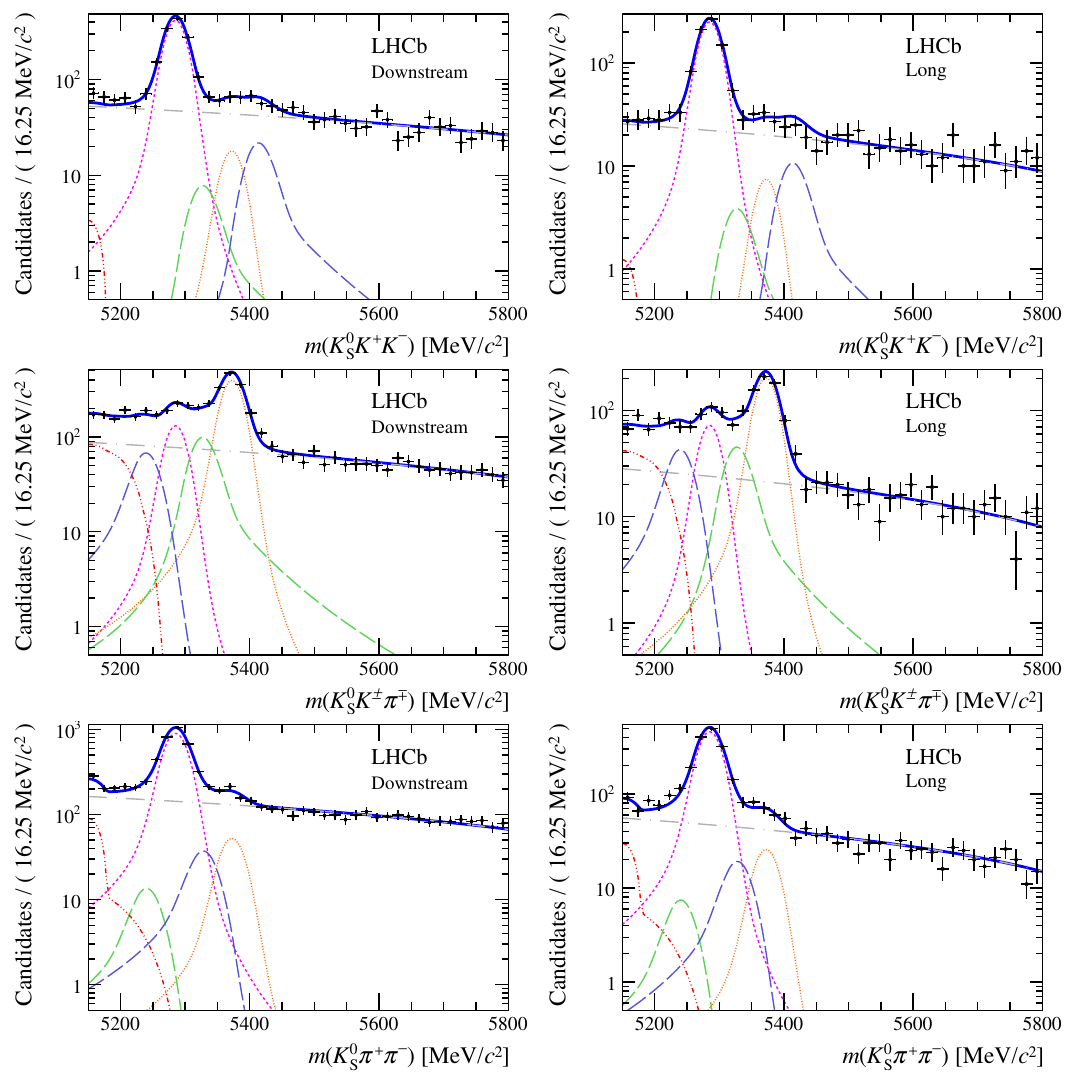
K (cid:6) (cid:25) (cid:7) and K 0 (cid:25) + (cid:25) (cid:0) Figure 1 . Invariant mass distributions of, from top to bottom, K 0 K + K (cid:0) , K 0 S S S candidates, summing the three periods of data taking, with the selection optimisation chosen for the favoured decay modes for (left) downstream and (right) long K 0 reconstruction categories. In S each plot, data are the black points with error bars and the total (cid:12)t model is overlaid (solid blue line). The B 0 ( B 0 ) signal components are the pink (orange) short-dashed (dotted) lines, while s fully reconstructed misidenti(cid:12)ed decays are the green and dark blue dashed lines close to the B 0 and B 0 peaks. The sum of the partially reconstructed contributions from B to open charm decays, s charmless hadronic decays, B 0 ! (cid:17) 0 K 0 and charmless radiative decays are the red dash triple-dotted S lines. The combinatorial background contribution is the gray long-dash dotted